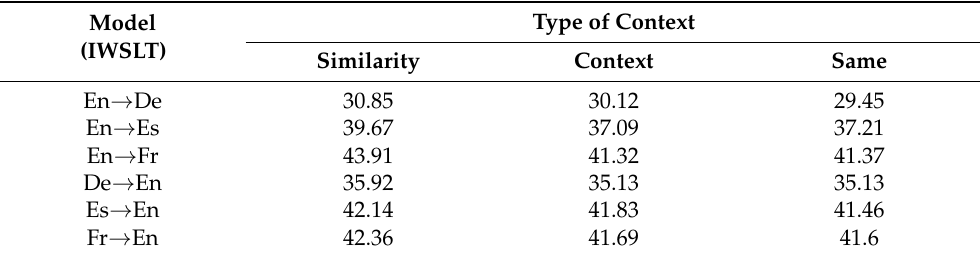
Table 6. BLEU scores of models with three types of